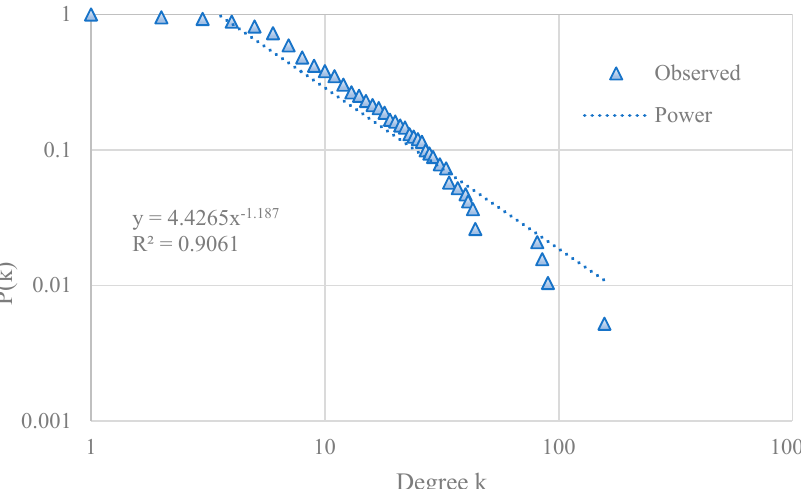
Figure 5. Cumulative degree distribution of the ENRRTP.